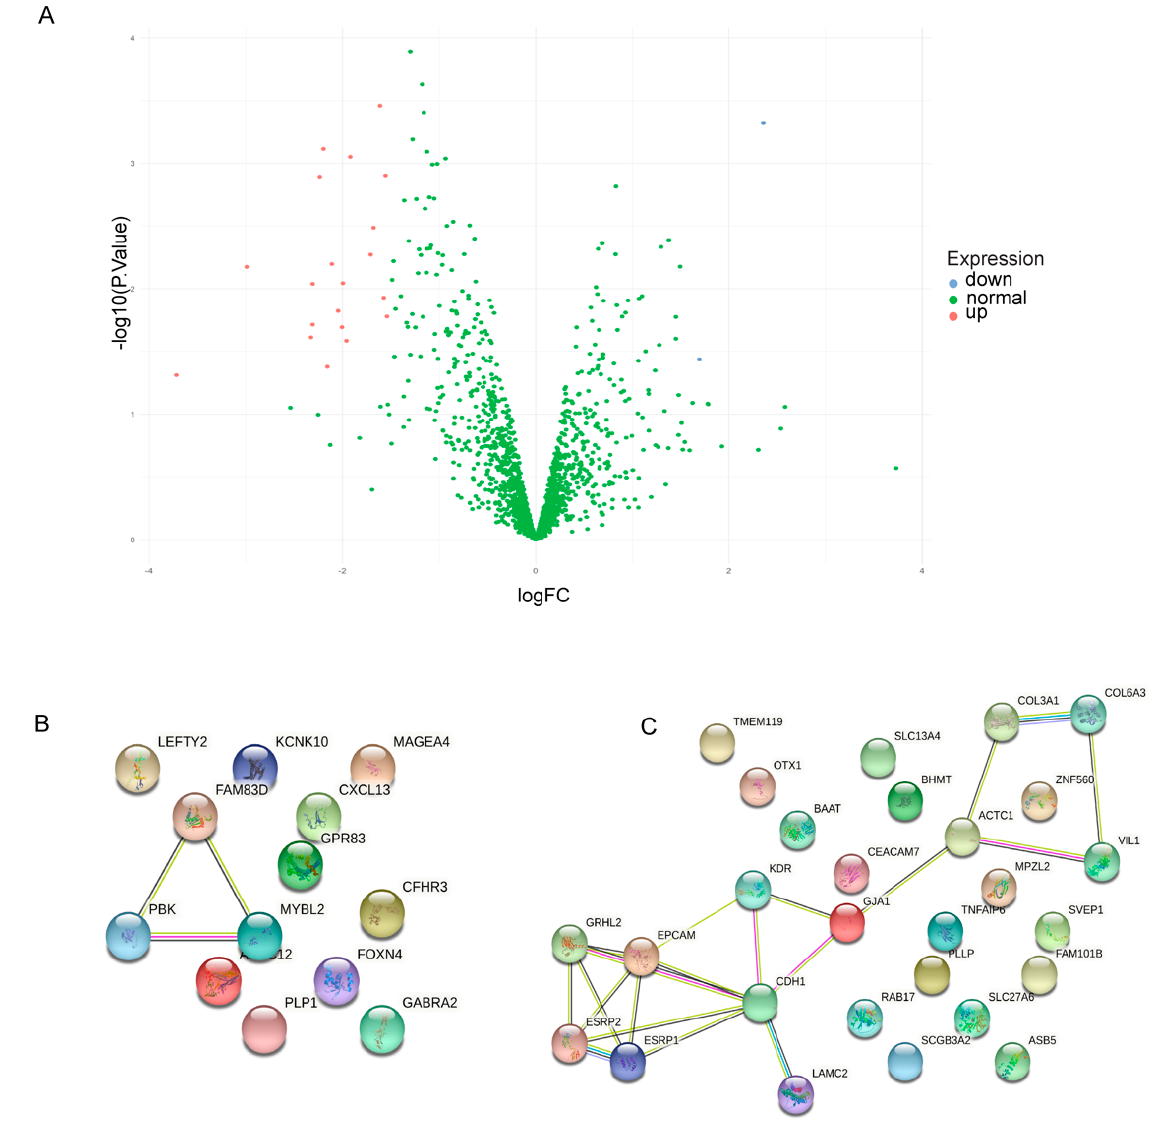
Figure 8. ( A ) Volcano plot showing the significantly up, red, and down, blue, regulated genes from the lavenderblush module in iPSC-derived neurons. String plots of down and up regulated genes from the iPSCs derived neurons from the OH dataset. ( B ) Upregulated genes and ( C ) Downregulated genes in RTT iPSCs-derived neurons. Note: The MT and TK datasets did not include iPSC-differentiated neuronal gene expression data.